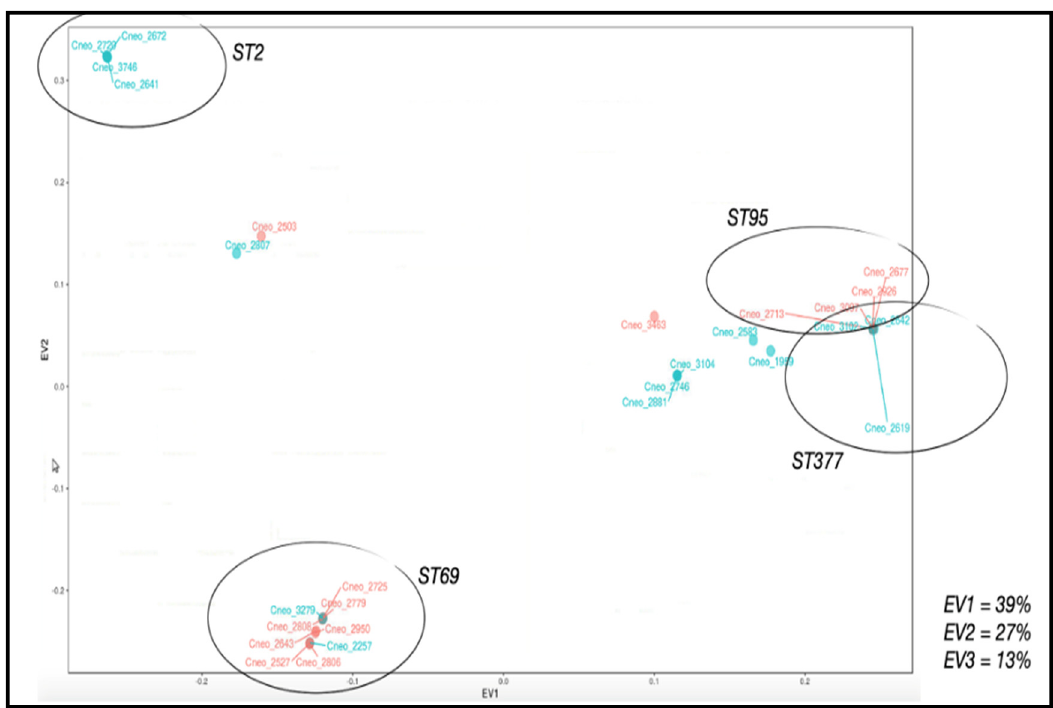
Figure 7. Principal component analysis for the genomic variants of 322 genes related to capsule, melanin, and pathogenicity. The figure shows the coordinates for each of the isolates as well as inclusion in the groups proposed for change in capsule size (red: isolates with high change; blue: with low change). The groups or clusters formed appear in circles.